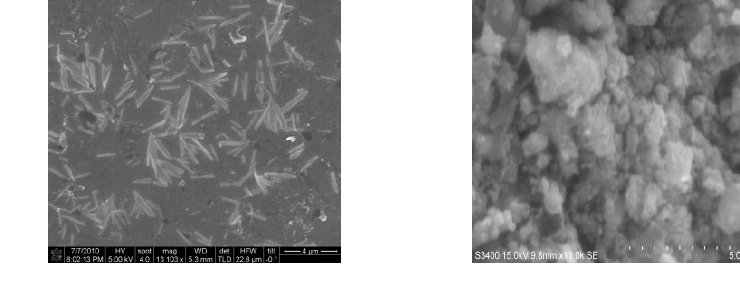
Figure 3. SEM images of PTSA doped tetrananiline prepared at different molar ratios of N- phenyl-1, 4-phenylenediamine to PTSA (a) 1:5, (b)